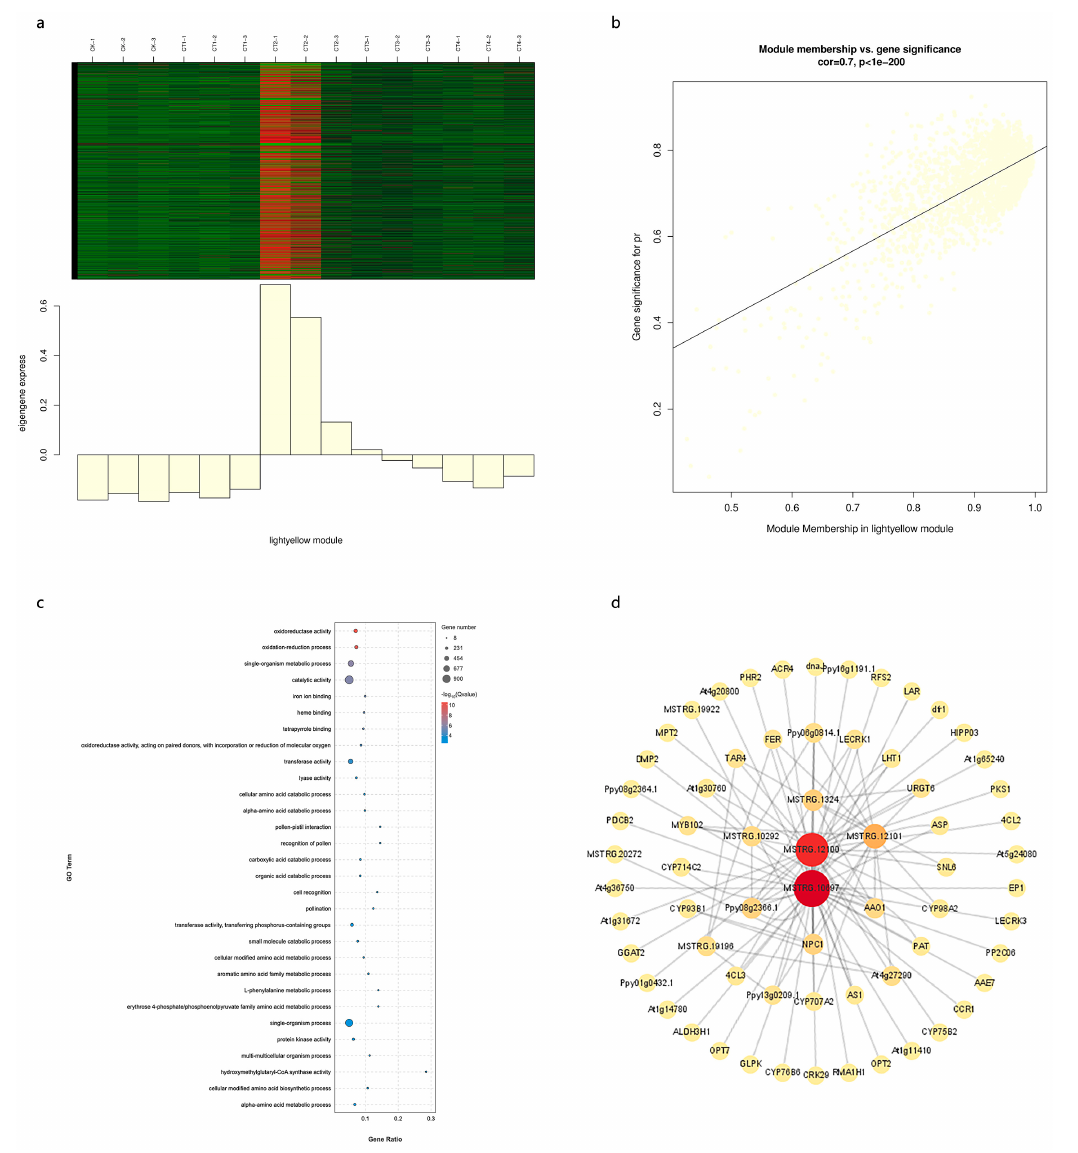
Figure 11. ( a ) Gene co-expression heat map of the light yellow module (upper panel) and expression of corresponding signature genes in each sample (lower panel). ( b ) A hub gene point map showed high connectivity and expressivity for MDA content and the light yellow module. The x-axis represents the correlation between the expression of each gene and the module, and the y-axis represents the correlation between each gene and the trait. ( c ) GO enrichment analysis of hub genes associated with MDA content in the light yellow module. ( d ) Co-expression network of hub genes in the light yellow module. The network was constructed using the top 100 hub genes, with a weight > 0.30.